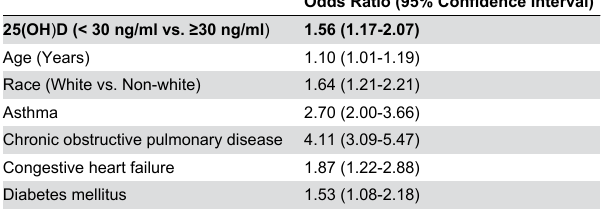
Table 2. Multivariable model of factors associated with odds Adjusted odds ratios for covariates independently associated with the risk of community-acquired pneumonia in participants with 25-hydroxyvitamin D levels <30 ng/mL versus ≥30